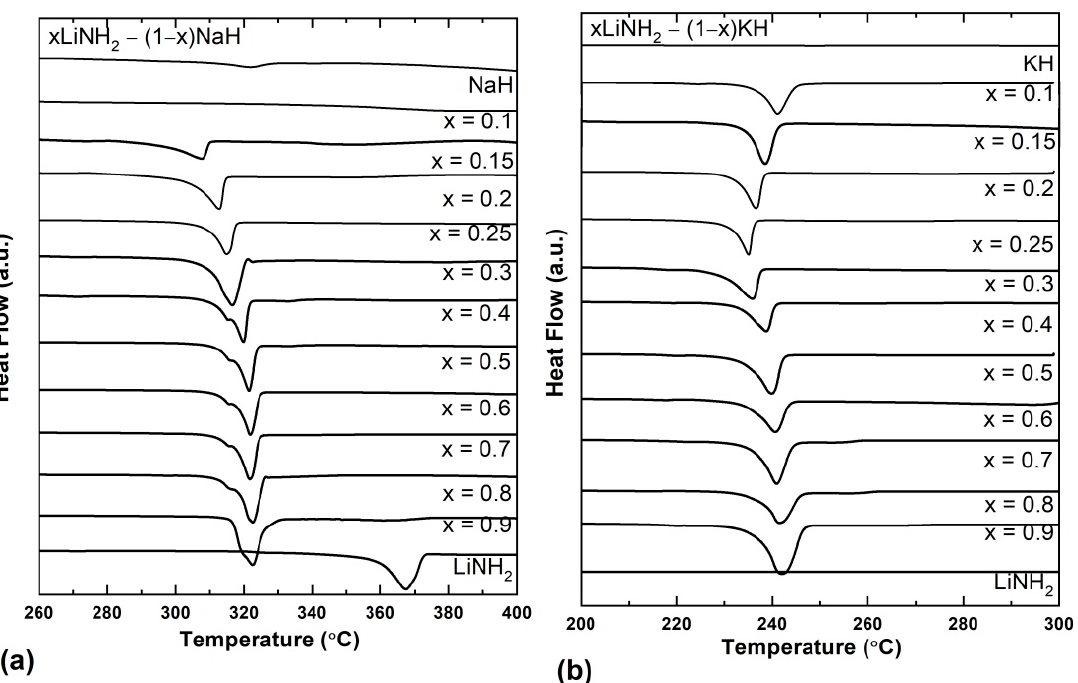
Figure 6. ( a ) DSC thermograms of xLiNH 2 -(1 − x) NaH ( b ) DSC thermograms of xLiNH 2 -(1 − x) KH at different compositions.